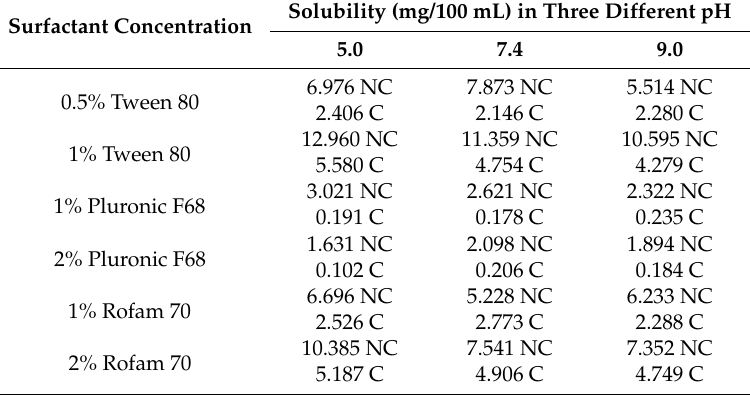
Table 1. Equilibrium solubility of megestrol acetate (mg/100 mL) in various pH/surfactant systems where NC—non-centrifuged, C—centrifuged.